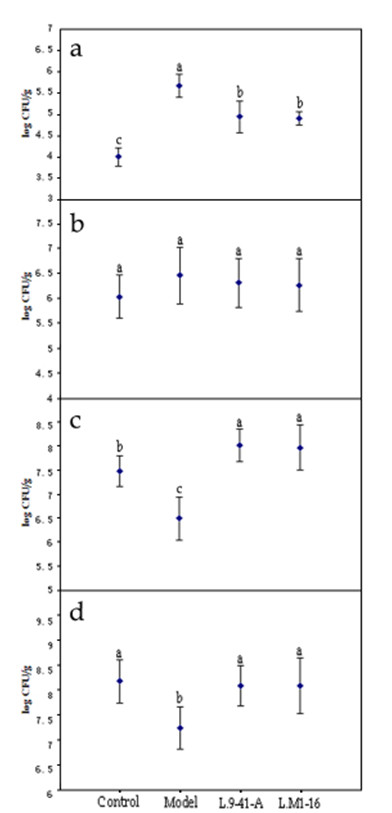
Populations of E. coli, Enterococcus faecalis, Lactobacillus, and Bifidobacterium in rat cecums in the four groups. Control group: normal diet; model group: high-cholesterol diet; L.9-41-A group: high-cholesterol diet + L. plantarum 9-41-A; L.M1-16 group: high-cholesterol diet + L. fermentum M1-16. a: Counts of E. coli colonies. b: Counts of Enterococcus faecalis colonies. c: Counts of Lactobacillus colonies. d: Counts of Bifidobacterium colonies. a,b,c Mean values with different superscript letters differ significantly (p < 0.05).